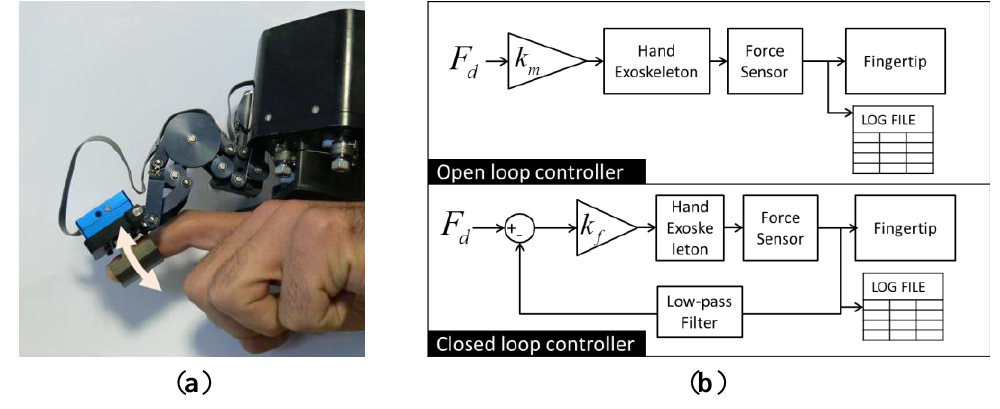
Figure 15. Picture of the experimental setup. ( a ) The finger of the 3-DoF hand exoskeleton is connected to a grounded reference plate. ( b ) Scheme of the two controllers that are